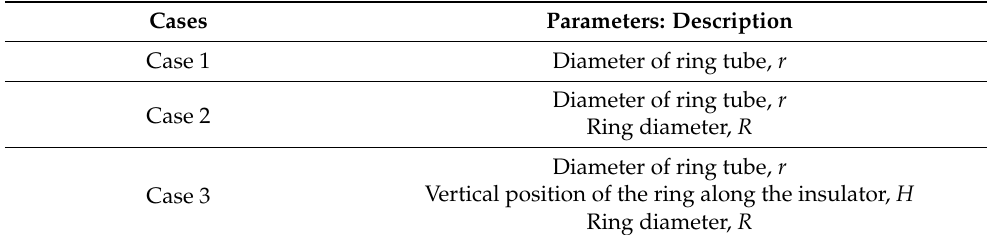
Table 5. Description of the case studies using optimisation